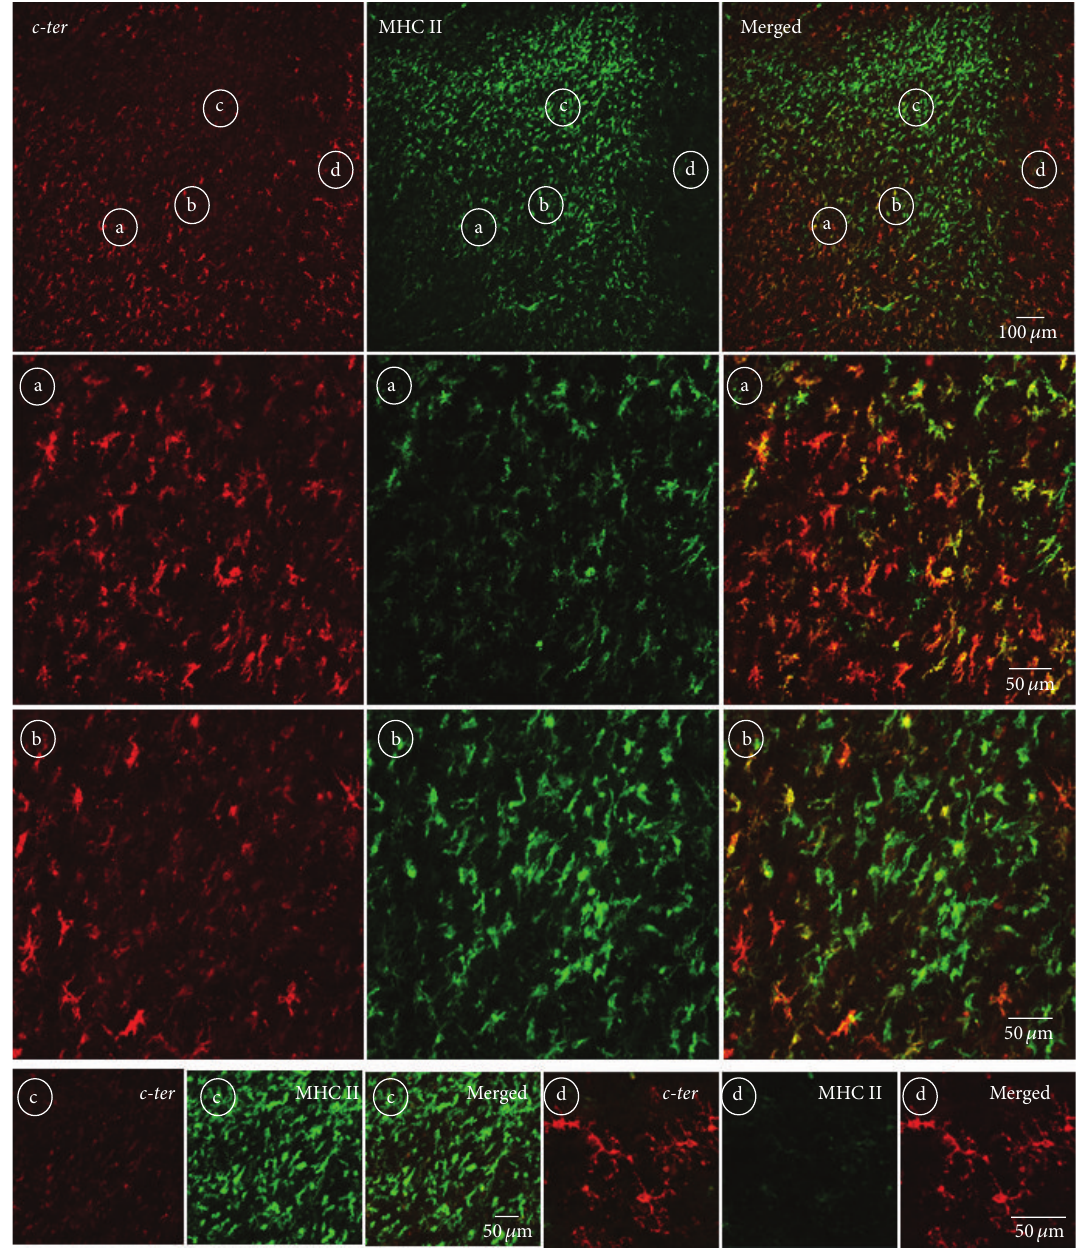
Figure 6: Regional distribution of P2Y 12 in proximity to MS lesions. Sections from SPMS frontal cortex were analyzed by double immunofluorescence and confocal microscopy for c-ter (red) and MHC II (green) immunoreactivity. In proximity to the demyelinating active cortical lesion expressing augmented positivity for MHC II, microglia gradually lose immunoreactivity for c-ter antibody. Microglia express differential immunoreactivity in the four chosen areas which are found inside (circled b-c) and around (circled a–d) a